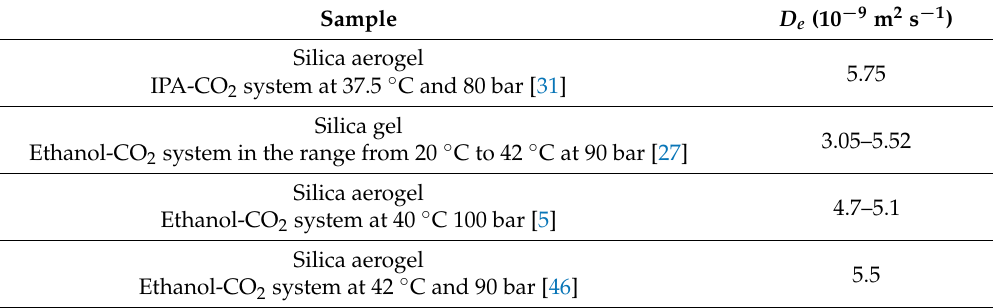
Table 4. Literature data on effective diffusion coefficients in